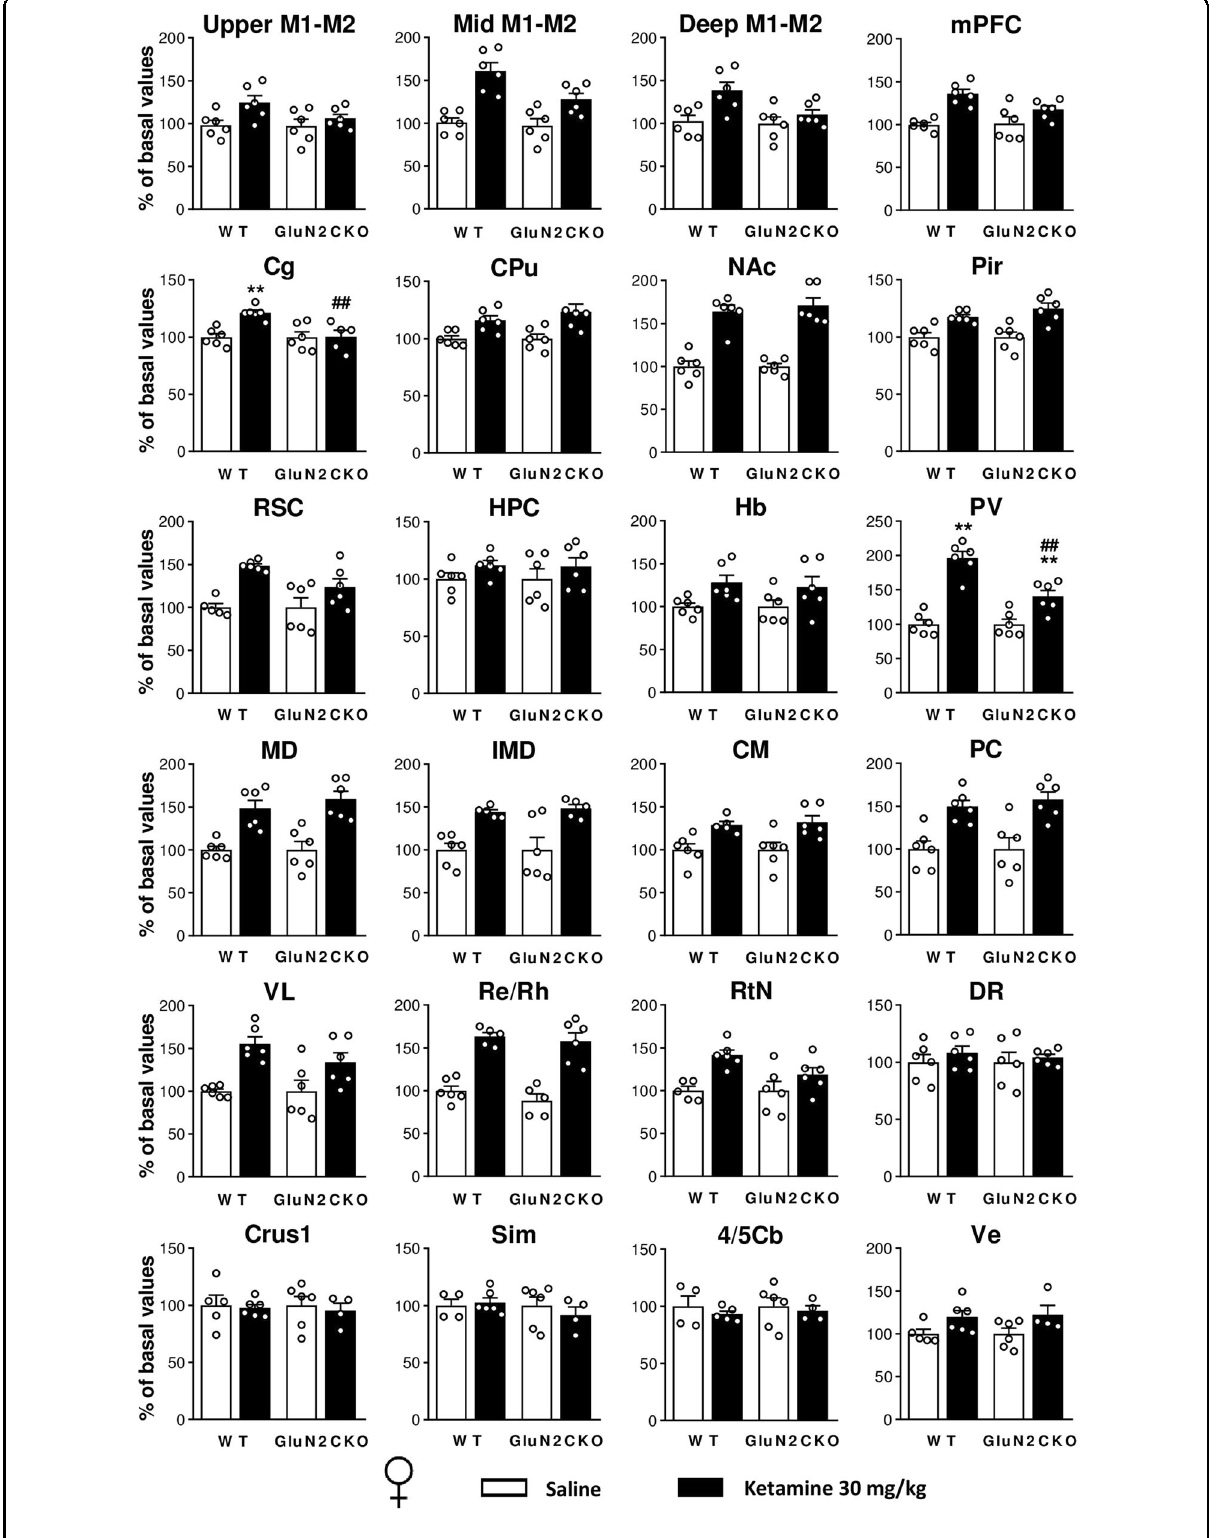
Fig. 4 (See legend on next